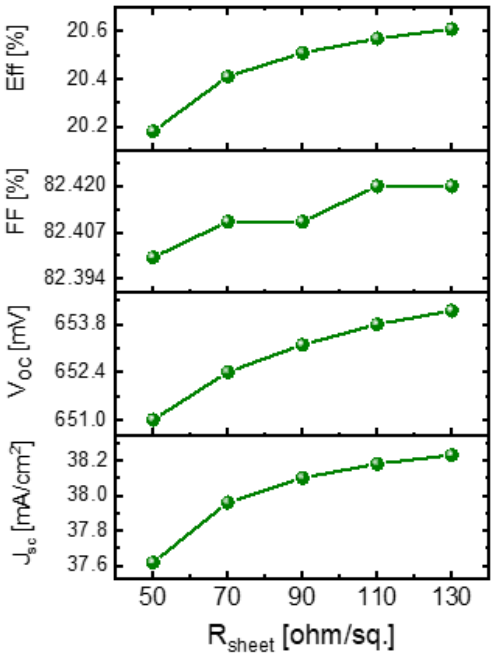
Figure 5. I–V characteristics as a function of R sheet .